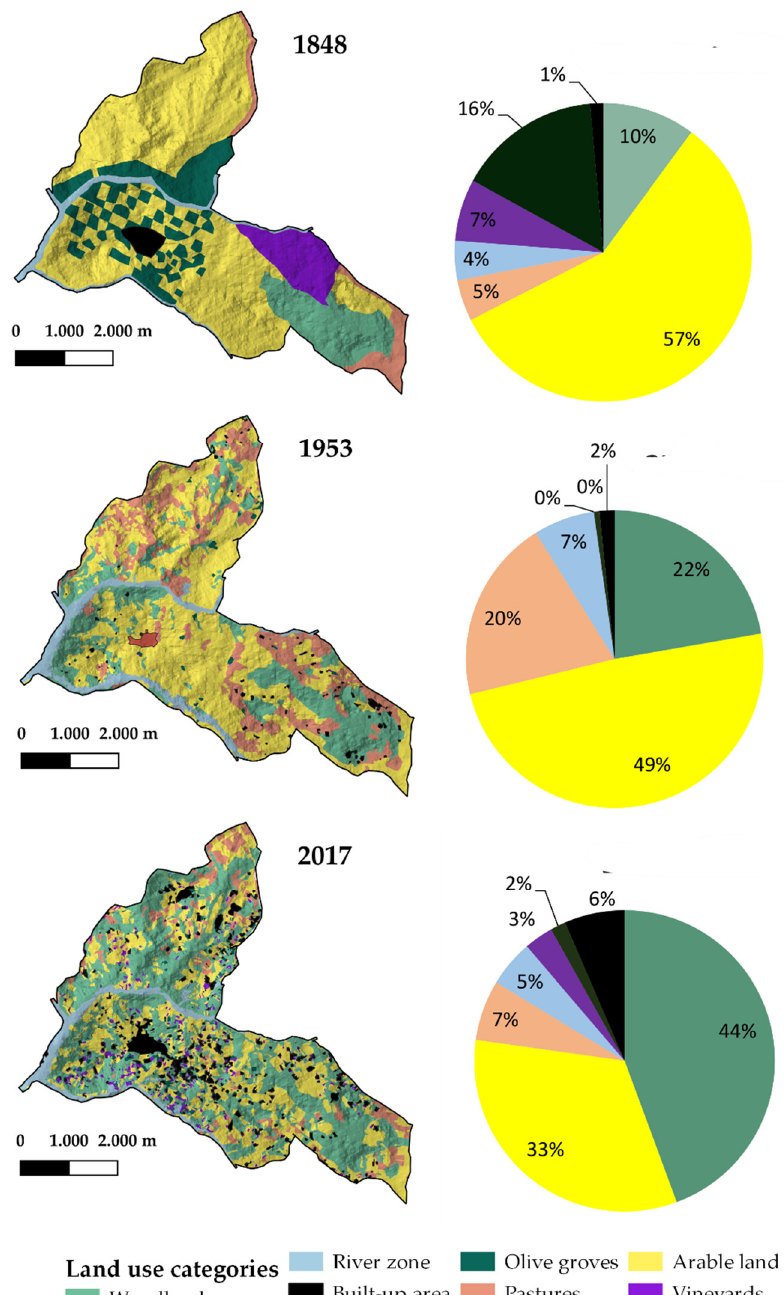
Figure 4. Land-use categories map and the evolution of main land use over the three different time periods.